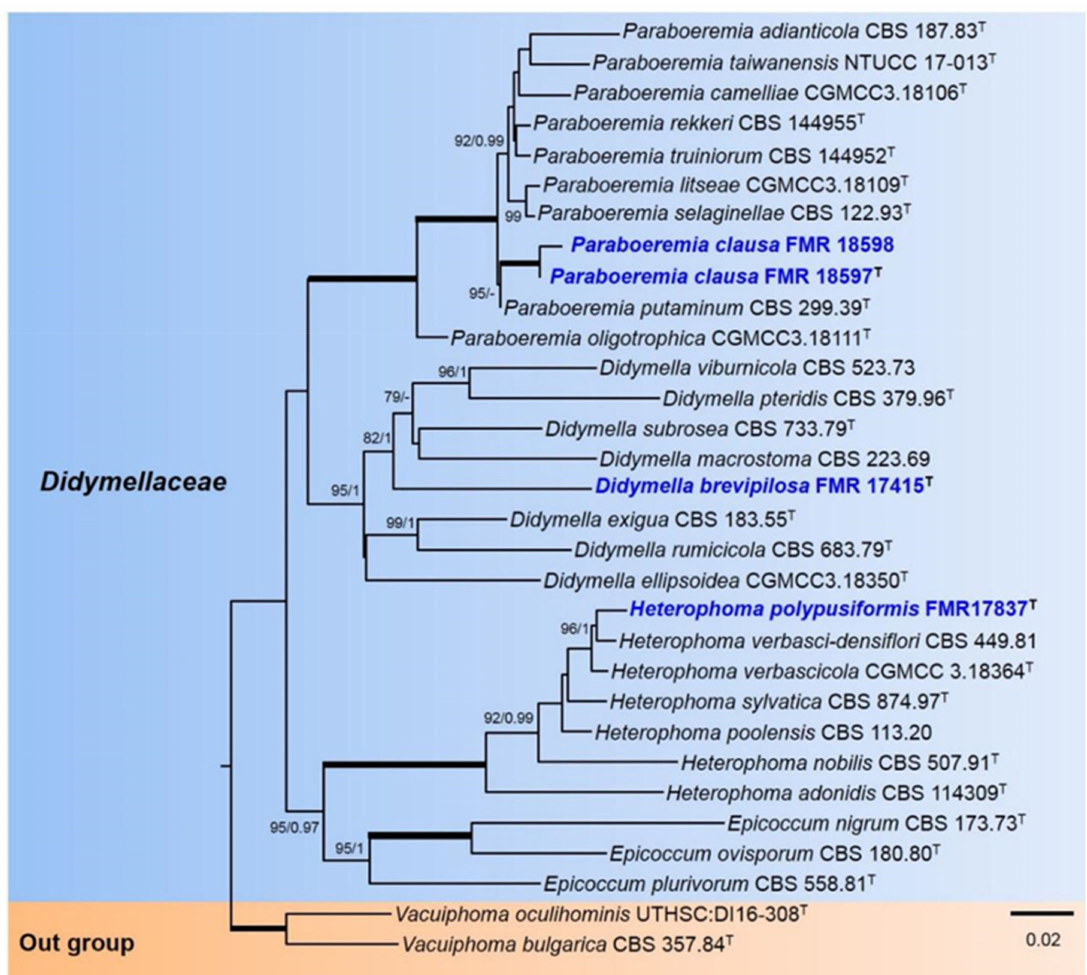
Figure 1. Phylogenetic tree inferred from a ML analysis based on a concatenated alignment of ITS, rpb2, and tub2